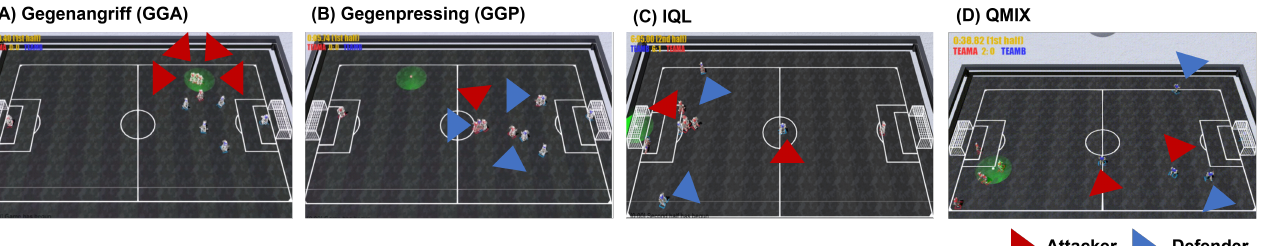
Figure 8. Screenshots of the simulations. Blue and red triangles refer to the defenders and the attackers, respectively. ( A ) GGA, ( B ) GGP, ( C ) QMIX, ( D )